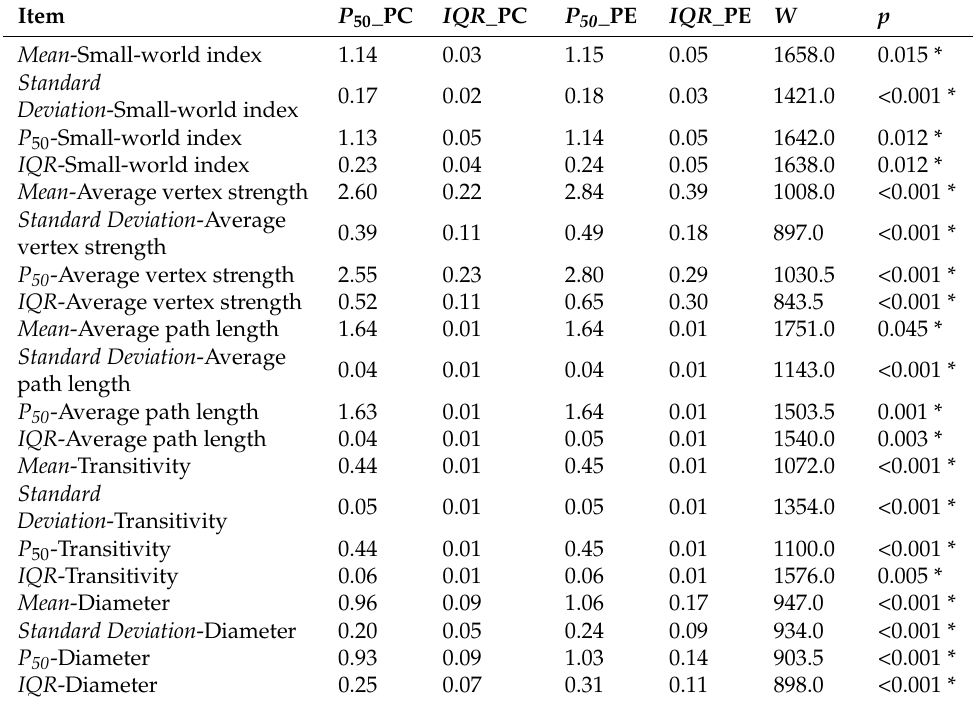
Table 5. Univariate analysis of dynamic network